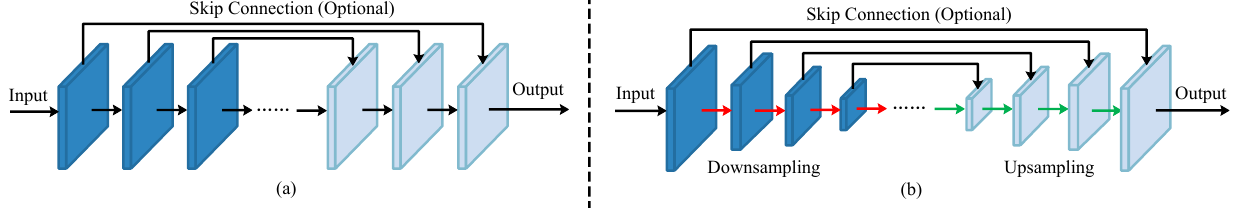
Figure 1. The two types of network structures used in existing DL-based methods: ( a ) plane encoder– decoder structure and ( b ) hourglass-shaped encoder–decoder